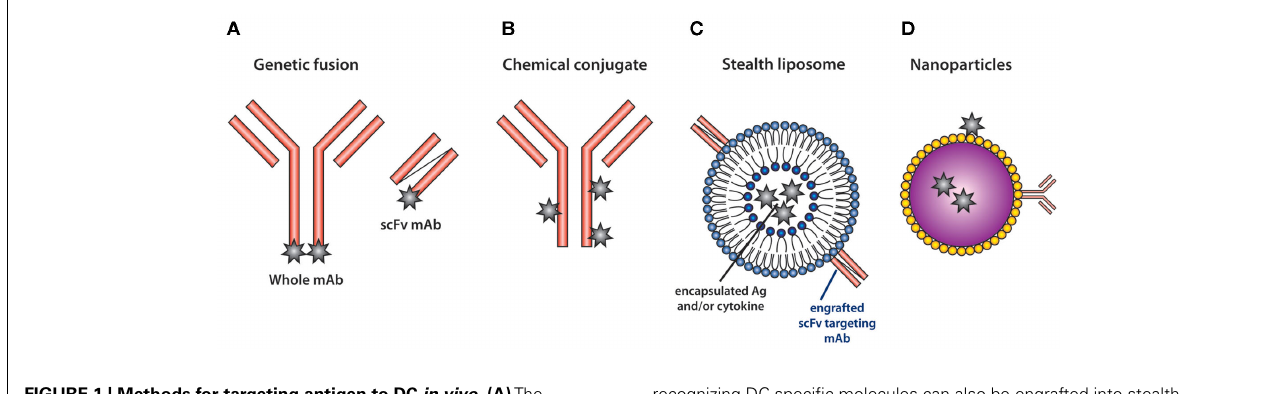
FIGURE 1 | Methods for targeting antigen to DC in vivo . (A) The heavy and light chain of the whole mAb or the single-chain fragments of the variable regions (scFv) are sequenced and genetically engineered to carry model Ag (star). Alternatively, (B) Ag can be chemically conjugated to whole mAb. (C) The scFv of the mAb